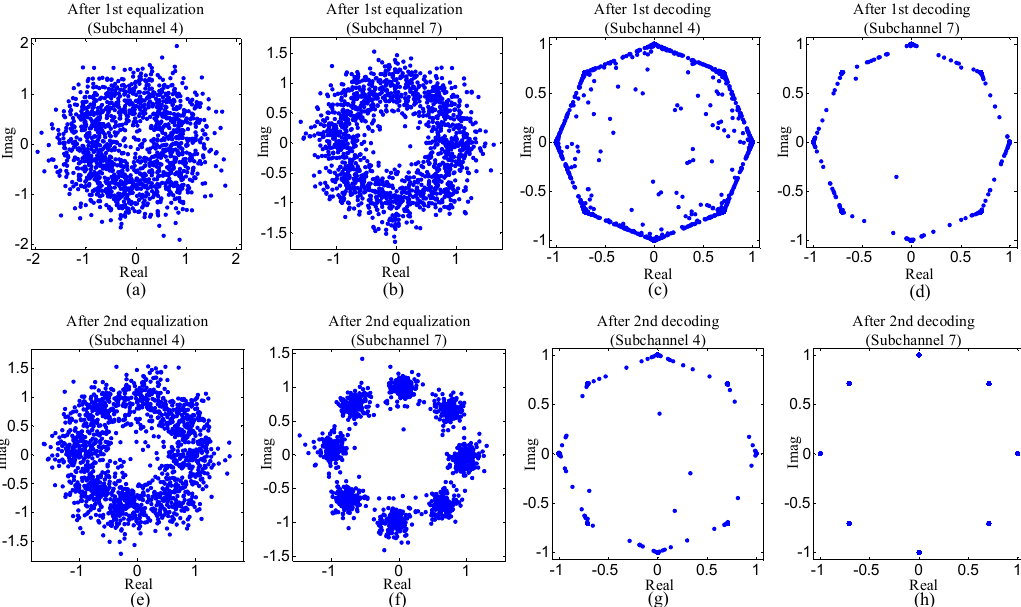
Figure 11. Scatterplots for subband four and subband seven of the proposed method with 8PSK mapping: ( a ), ( b ), ( e ) and ( f ) the scatterplots indicating the estimated symbols after equalization; ( c ), ( d ), ( g ) and ( h ) the scatterplots indicating the mean of the symbols after decoding. Three observations can be obtained from Figures 10 and 11. Firstly, the dots in the